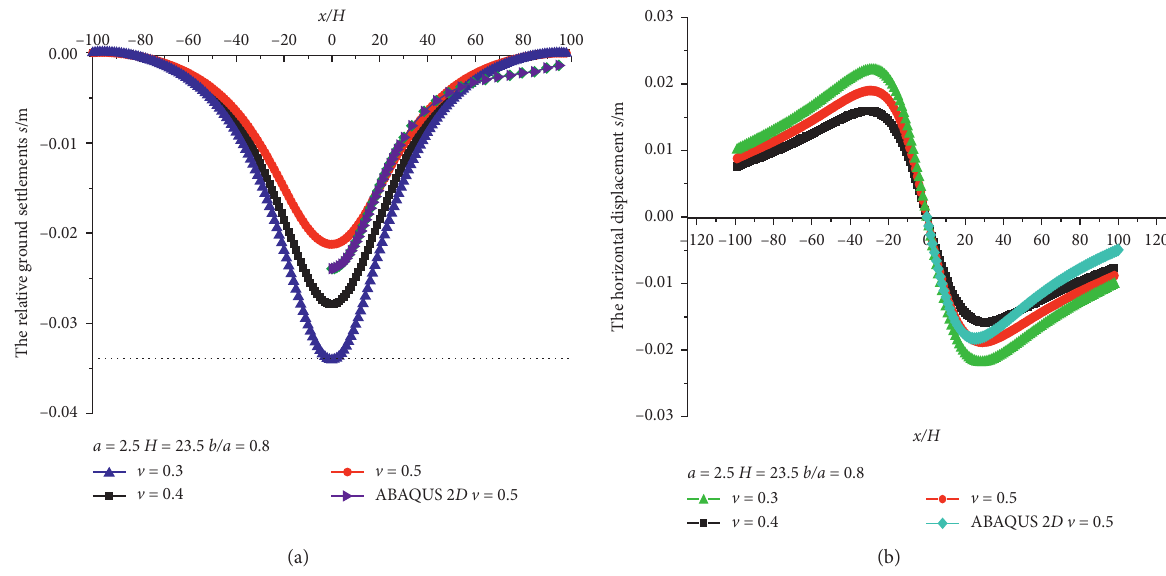
Figure 13: Influence of Poisson’s ratio on the horizontal and vertical displacements of ground induced by the elliptical tunnel cavity’s deformation. (a) Vertical displacement of ground. (b) Horizontal displacement of